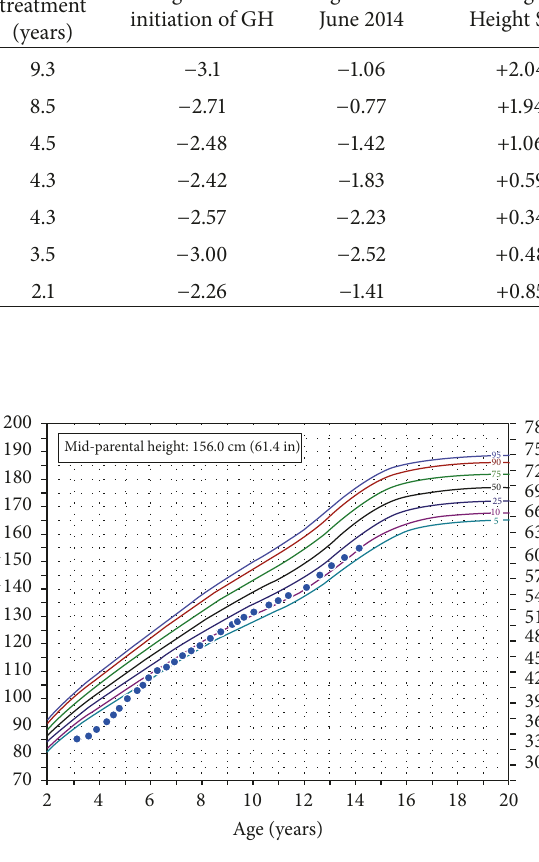
Figure 1: Height growth chart for Case 1